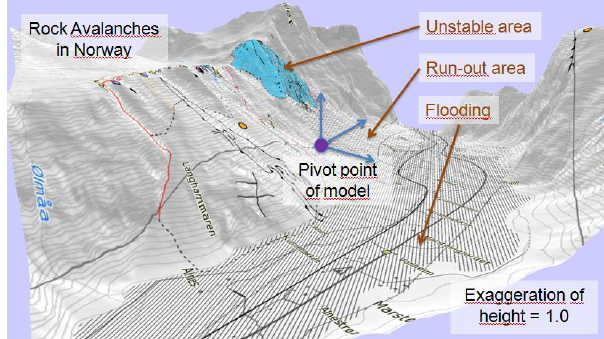
Figure 12: Unstable rock slopes at mountain